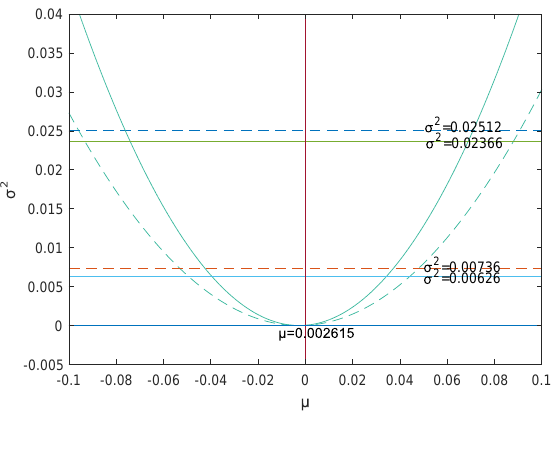
Figure 5. The contrast of two methods.